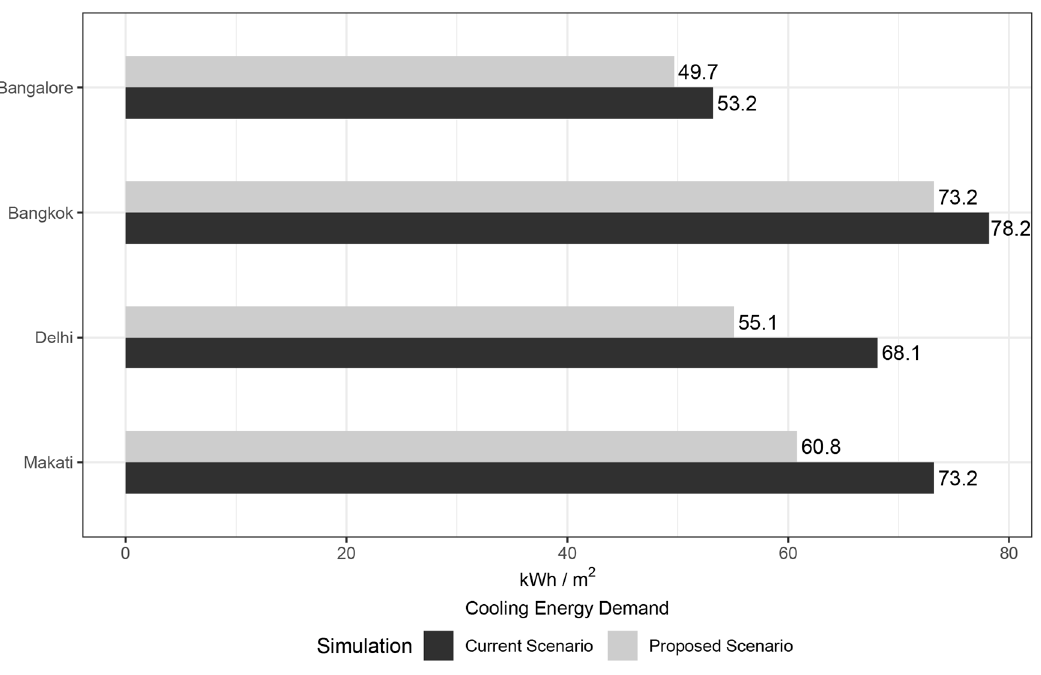
Figure 5. Average hourly cooling energy loads for the both the current (dark) and proposed (light) setpoint scenarios. Both scenarios are plotted for cooling loads in the hottest week in an average year